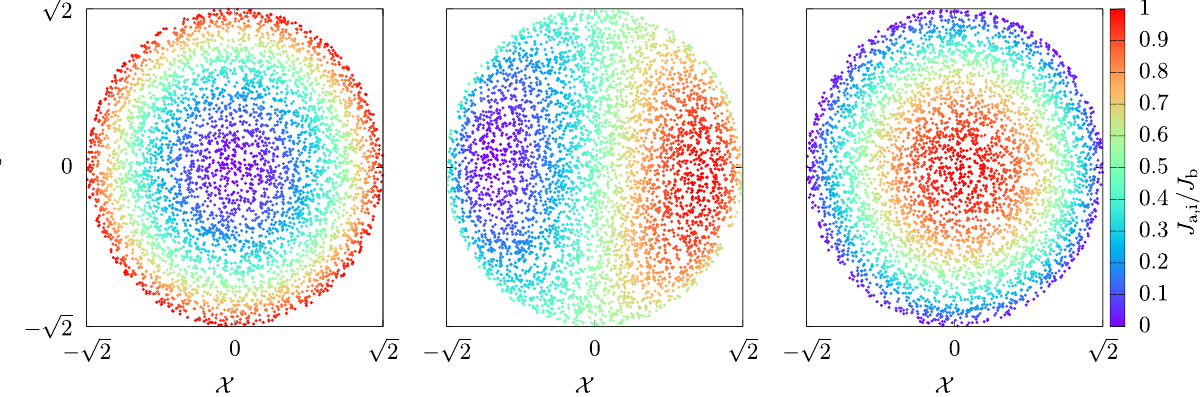
FIG. 3. Distribution of particles in ð X ; Y Þ space from simulation of map (60) for δ ¼ − 0 . 1 (left), δ ¼ 0 (center), and δ ¼ 0 . 1 (right), 2 × 10 − 4 . The colors encode the value of the initial action J for a set of initial conditions at fixed J b ¼ at the end of the exchange their action values J a ; f